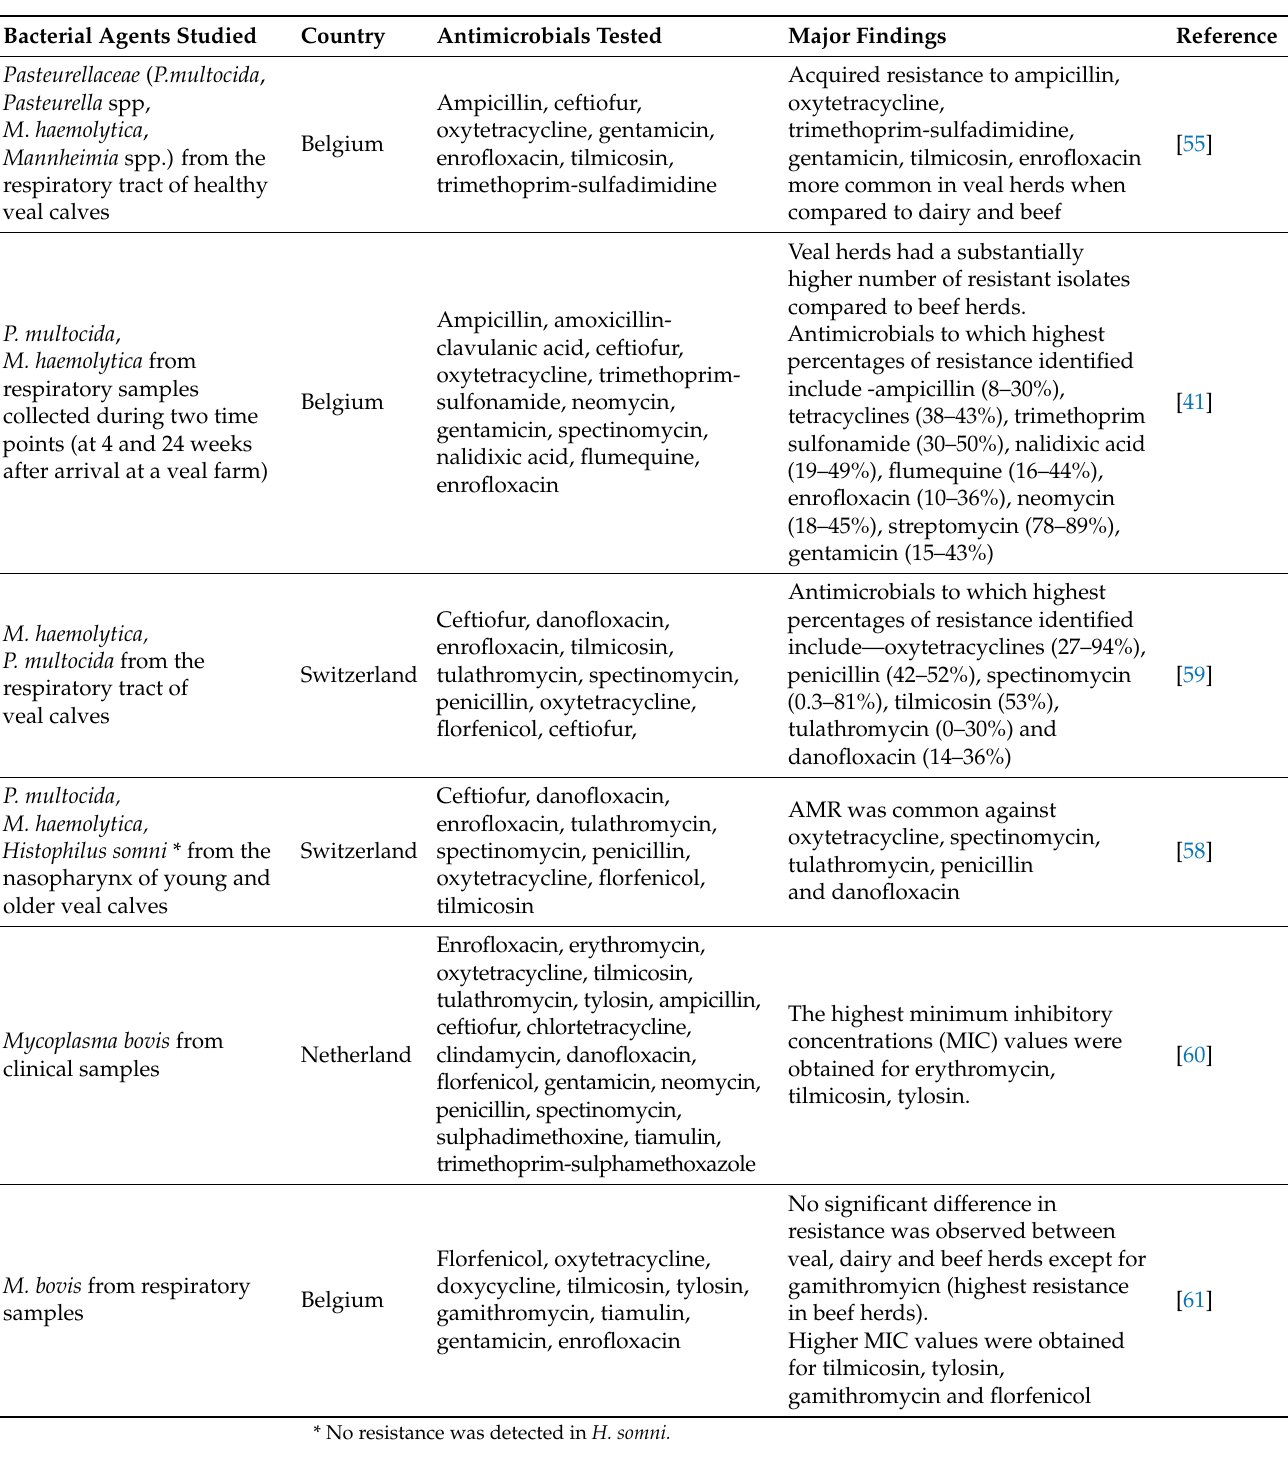
Table 2. Summary of research that studied resistance among bovine respiratory pathogens in surplus calves: The table below shows the source of the different isolates included in the study, country in which the study was conducted, panel of antimicrobials that were tested against the bacterial agent and, major findings from the